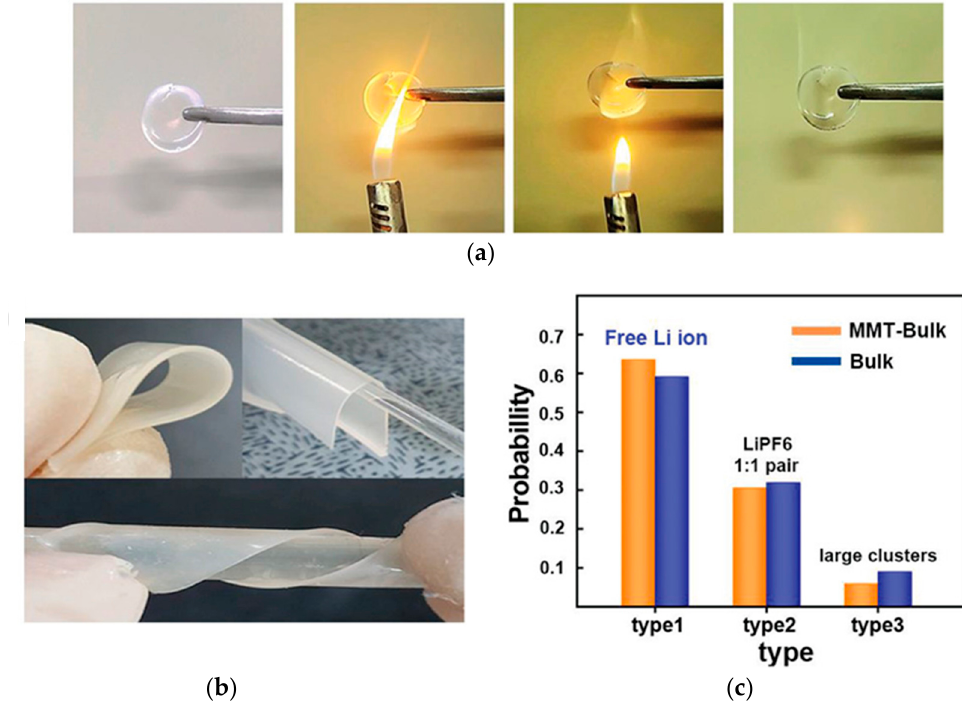
Figure 7. ( a ) Flammability test of the CGPEs; ( b ) Photographs of the Flexibility CPEs; and ( c ) The distribution Li ion clusters. Type 1: Free Li ion, Type 2: One Li-ion PF 6 pair, Type 3: One Li-two PF 6 cluster, Two Li-ion PF 6 cluster, and the others. Reprinted/adapted with permission from Ref. [99].